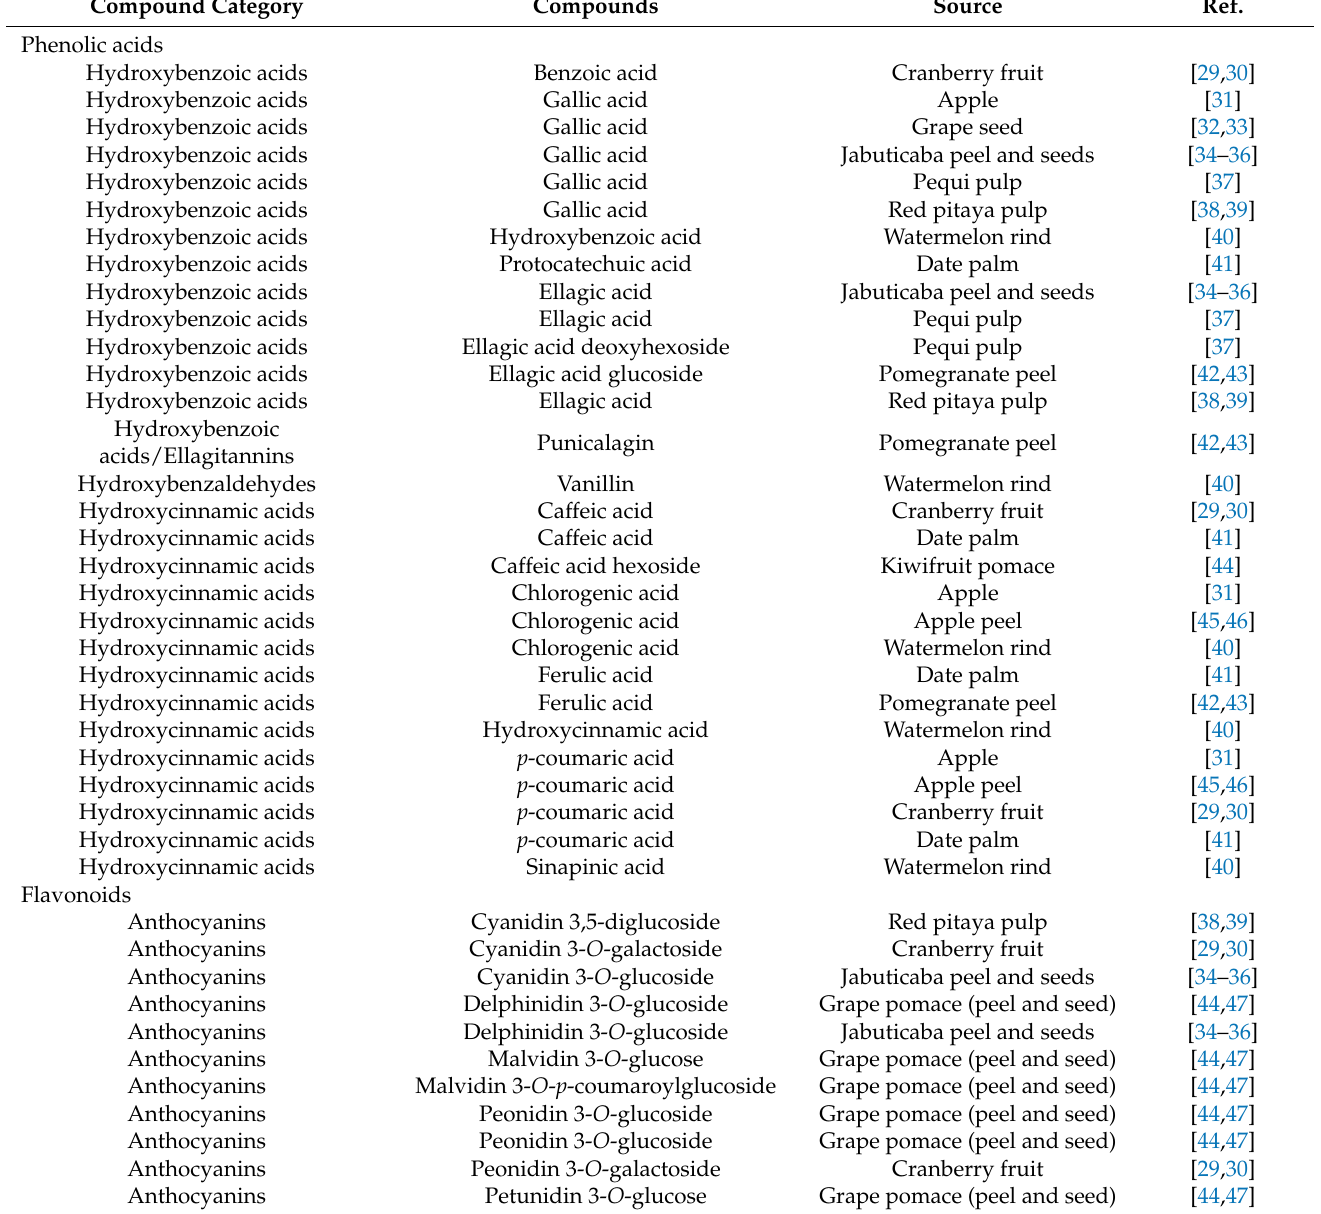
Table 1. Polyphenols found in